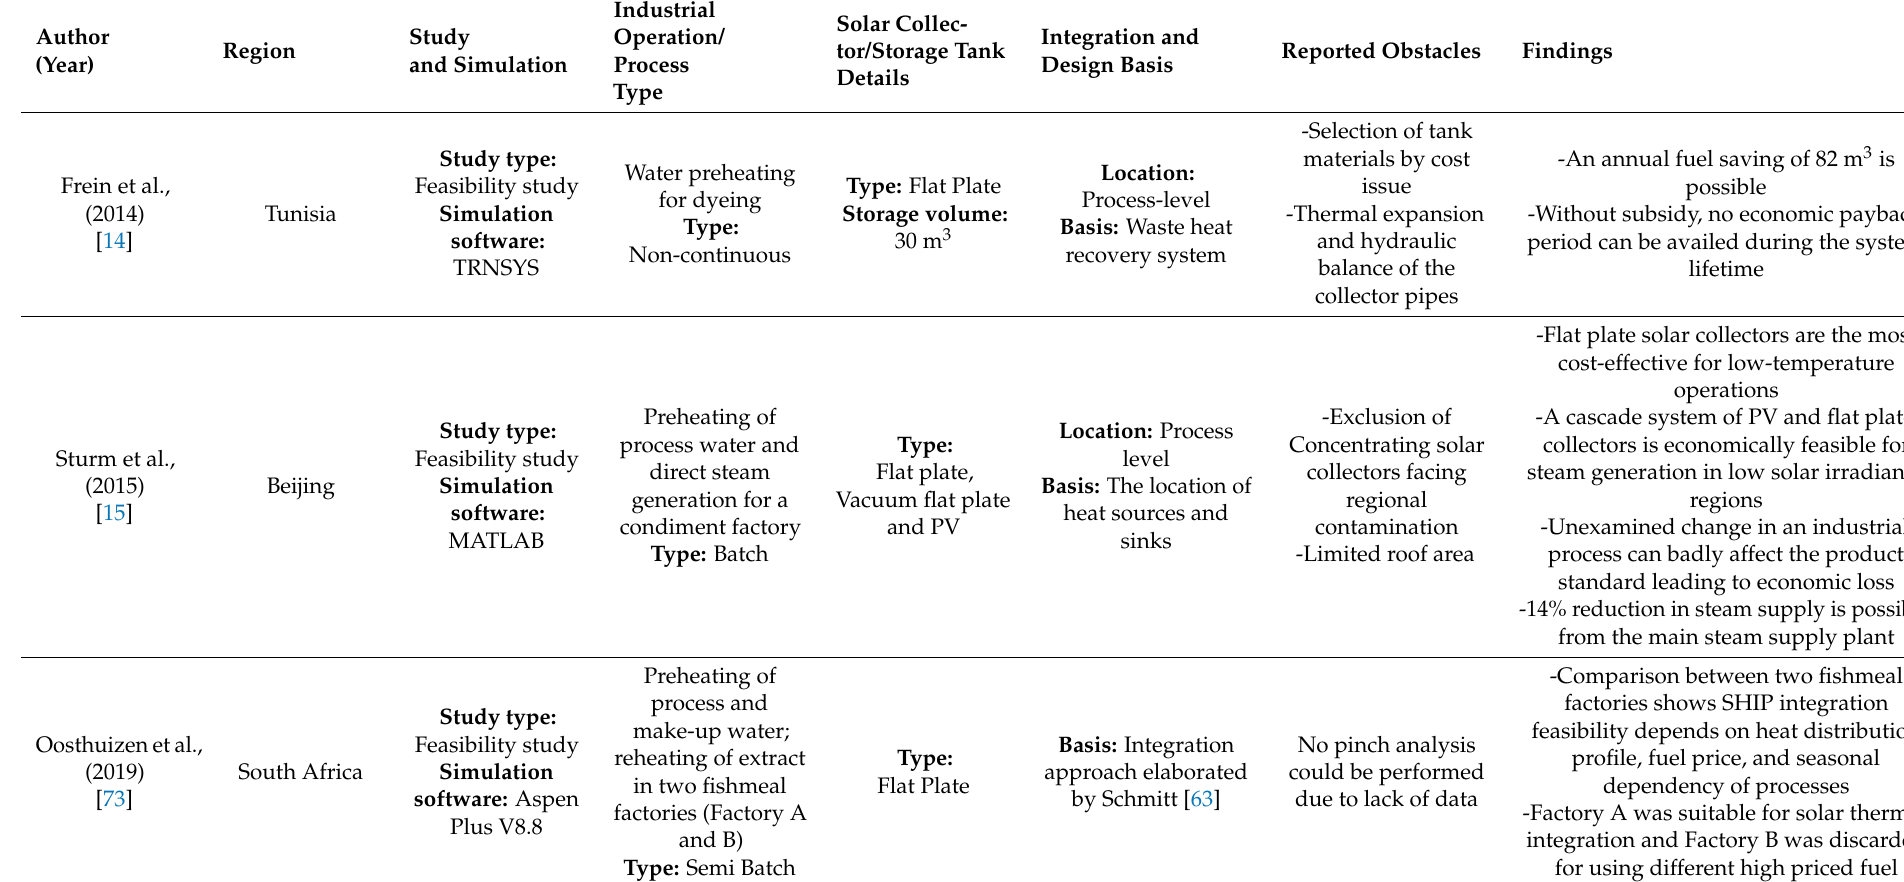
Table 8. Design Parameters of Solar Industrial Process Heating Systems from the